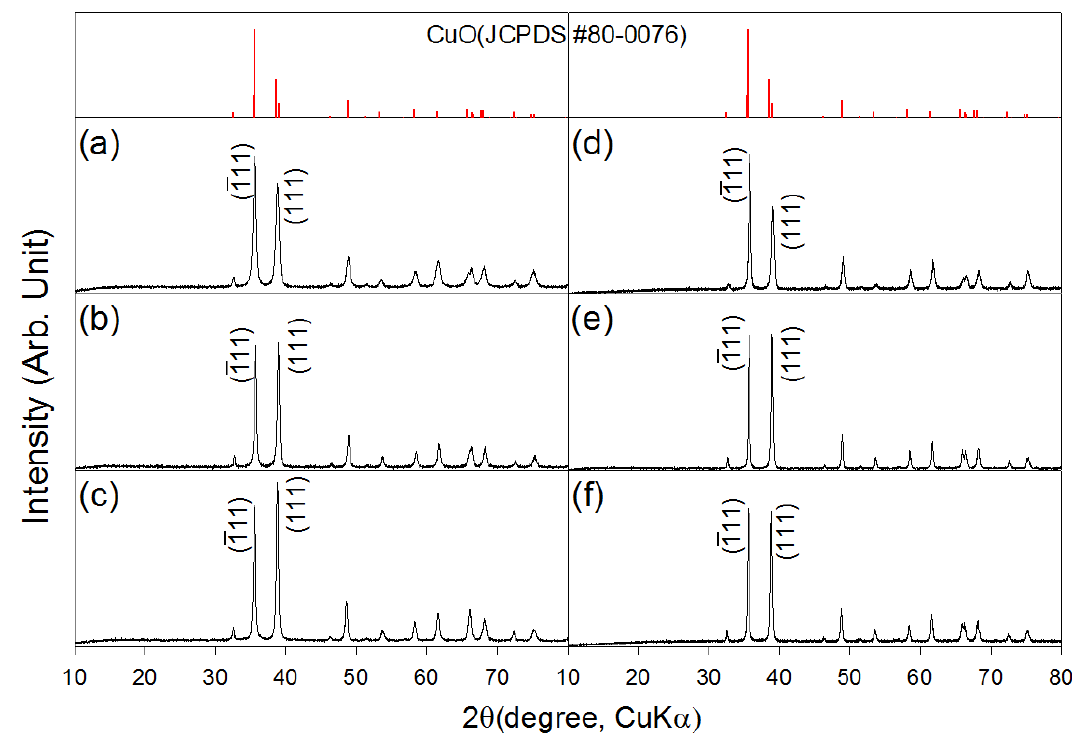
Figure 1. XRD patterns of CuO and Cr-doped CuO nanostructures. ( a ) as-prepared CuO nanosheets; ( b ) as-prepared 0.76Cr-CuO nanosheets; ( c ) as-prepared 2.2Cr-CuO nanorods, ( d ) CuO nanosheets after heat treatment at 500 °C for 1 h , ( e ) 0.76Cr-CuO nanosheets